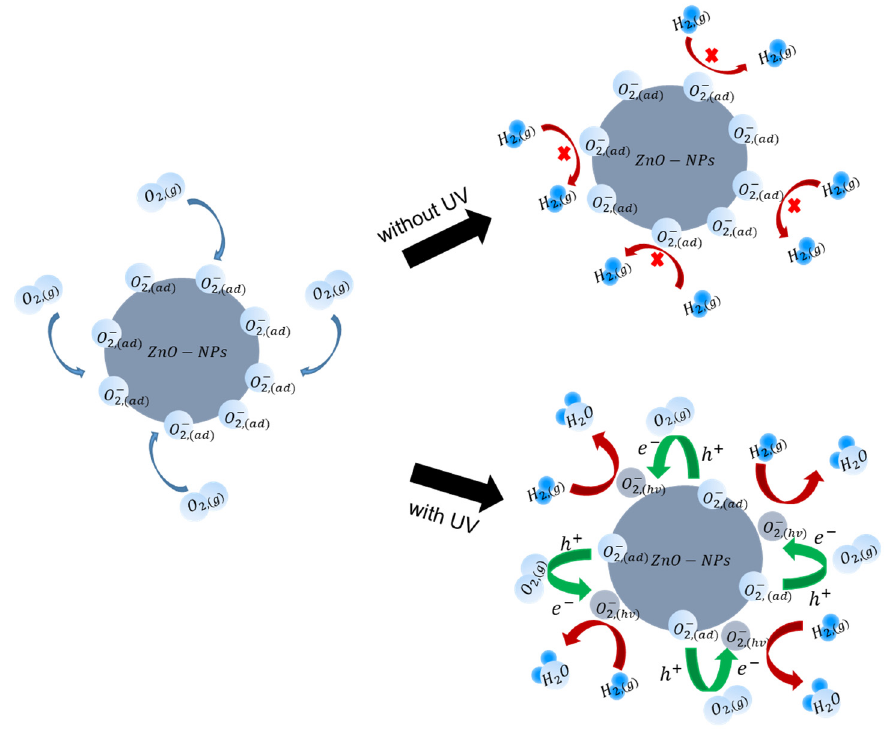
Figure 7. Schematic illustration of UV photocatalytic reaction of hydrogen with ZnO-NP.